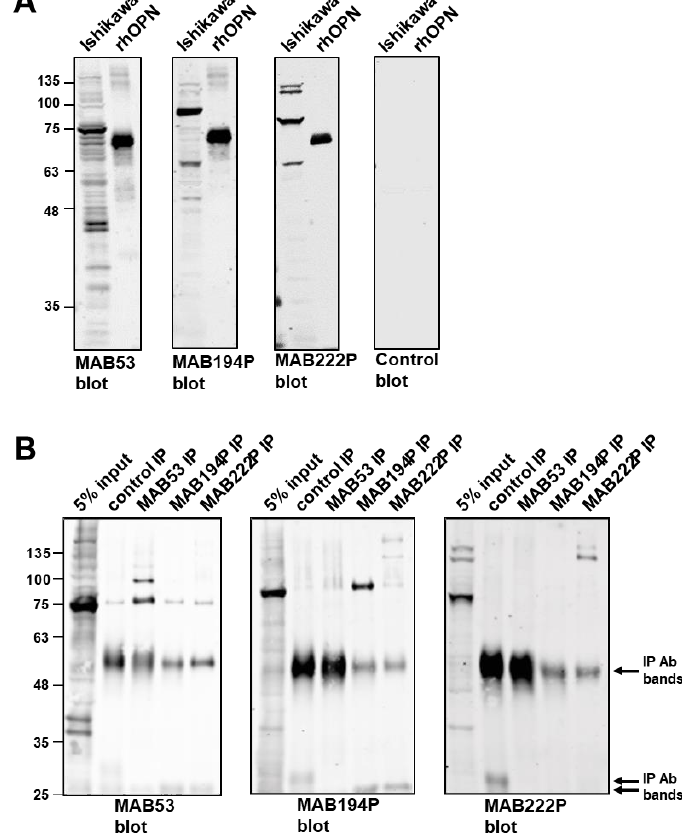
Figure 1. ( A ) Western blots of Ishikawa cell lysate and recombinant human OPN (rhOPN), using monoclonal antibodies MAB53, MAB194P, MAB222P and a non-specific mouse IgG control antibody. ( B ) Immunoprecipitates were produced from Ishikawa cell lysates using MAB53, MAB194P, MAB222P or control antibody before western blotting with MAB53, MAB194P and MAB222P.